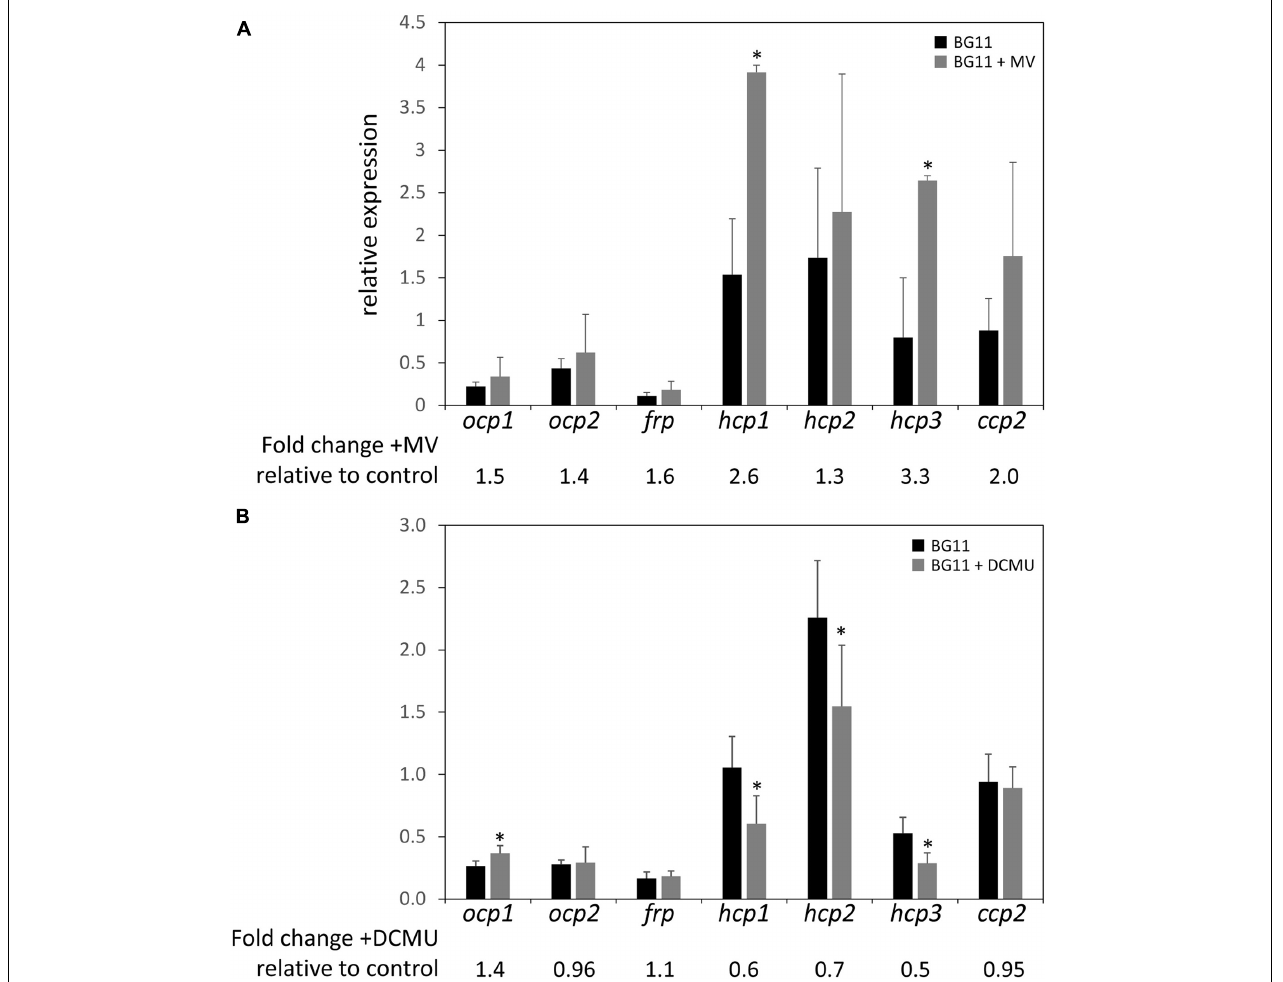
FIGURE 6 | Expression of ocp homologs in the presence of methyl viologen or DCMU. The expression levels of ocp1 , ocp2 , frp , hcp1 , hcp2 , hcp3 , and ccp2 were measured using qPCR, comparing samples incubated in the presence of 0.03 µ M methyl viologen (A) or 10 µ M DCMU (B) for 24 h to untreated samples ( ± SD, n = 4–6). ∗ p < 0.05 as determined by a two tailed Student’s t -test for the comparison of the treated and untreated